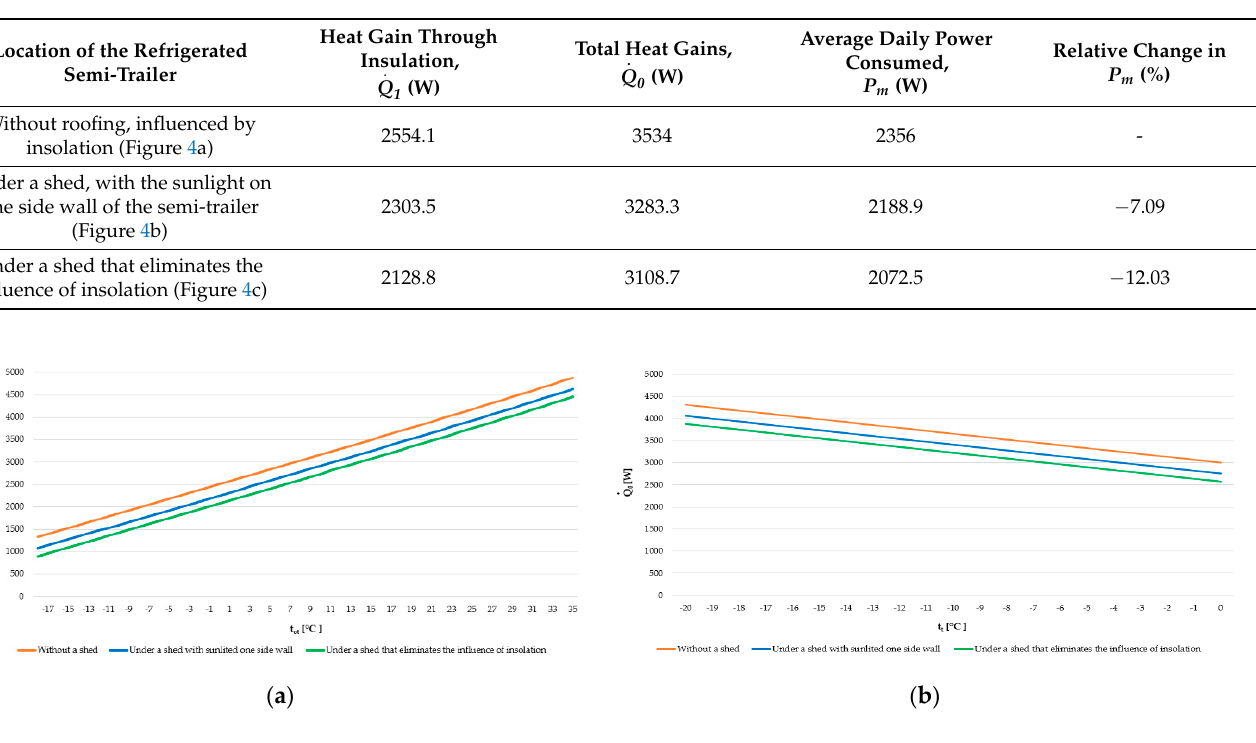
Table 3. The results of heat load calculations and the average daily power consumed by the refrigera- tion unit of a semi-trailer in different parking locations.